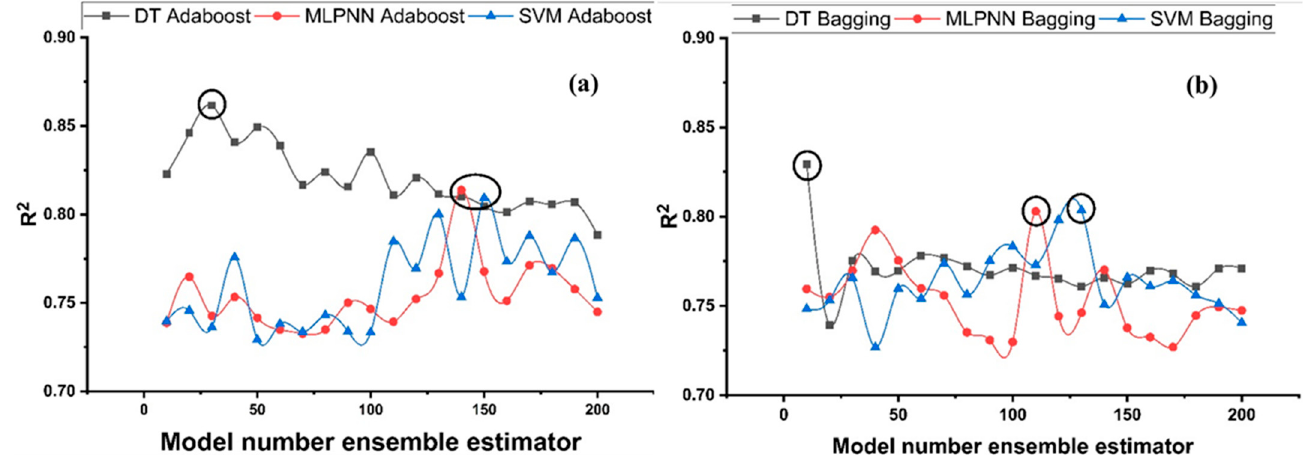
Figure 11 . R 2 for tensile strength ensemble models with the different sub-models; ( a ) Adaboost; ( b ) Bagging .